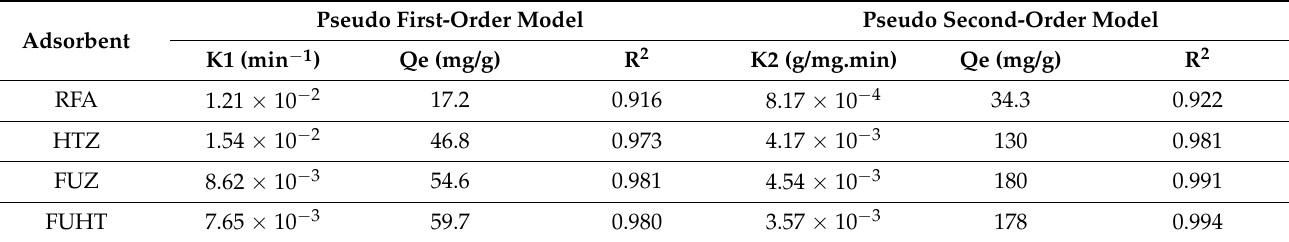
Table 5. Kinetics study for adsorption of Pb (II) on RFA and Na-zeolites. Pseudo First-Order Model Pseudo Second-Order Adsorbent